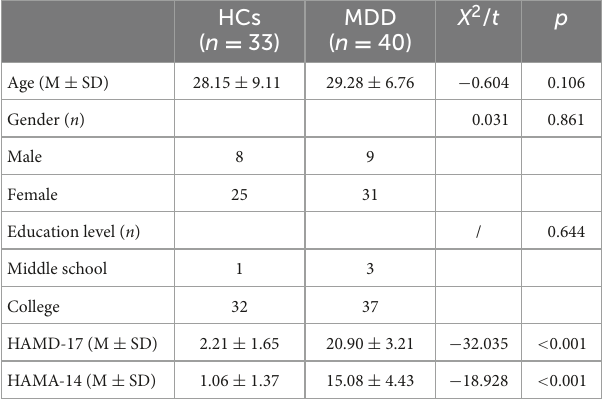
TABLE 1 Demographic and clinical characteristics of MDD and HCs.